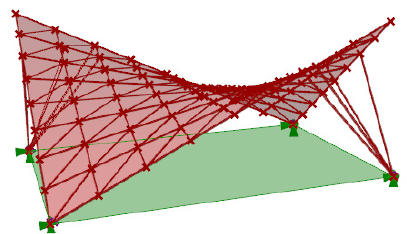
Figure 8. The hyperbolic paraboloid roof with branches supported on the ground.